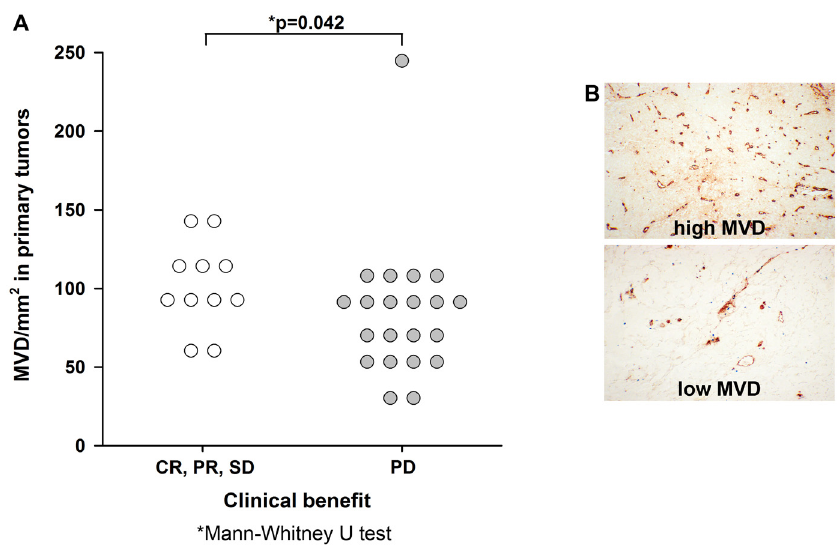
Fig 3. High microvessel density (MVD) in primary tumors predicts clinical benefit to treatment with bevacizumab. (A) MVD in primary melanomas grouped by treatment response. Median MVD in primary melanomas is significantly higher in patients with clinical benefit. CR: complete clinical response, PR: partial response, SD: stable disease, PD: progressive disease (B) Immunohistochemical staining showing high and low MVD. Original magnification